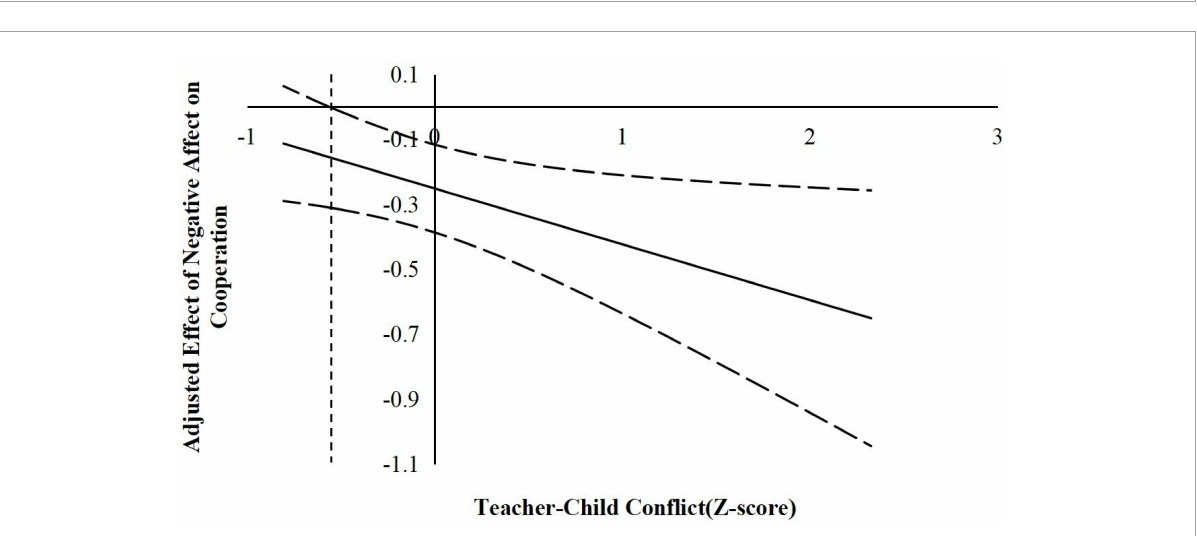
FIGURE3 The moderating effect of teacher-child conflict in the prediction of children’s negative affect on cooperation. The dashed vertical line indicates the point along the teacher-child conflict in which the negative affect regression coefficient transitions from significance (right of the dashed vertical line) to non-statistical significance (left of the dashed vertical line). The value of the dashed vertical line was